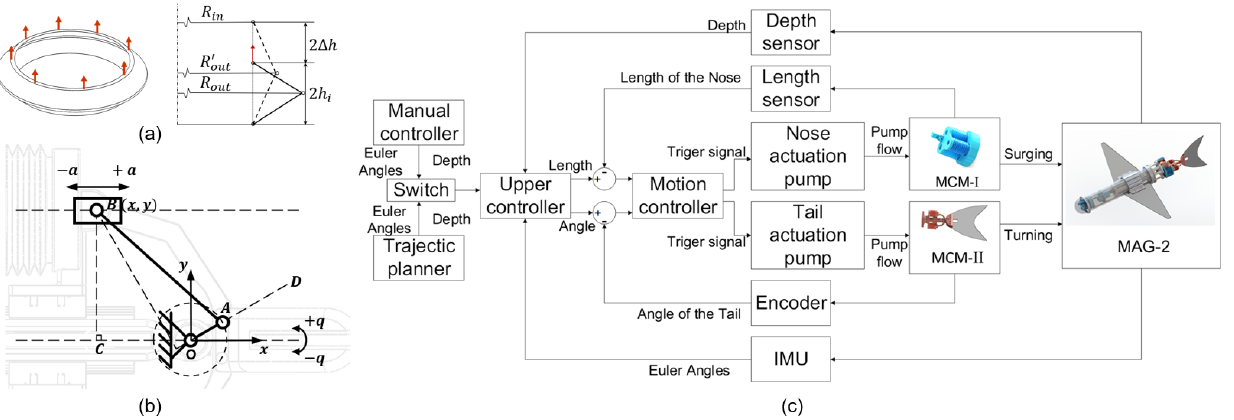
Figure 4. Modeling and control of the MAG-2. ( a ) Model of a single SBC actuator, ( b ) model of the MCM-II mechanism, ( c ) control diagram of the system.